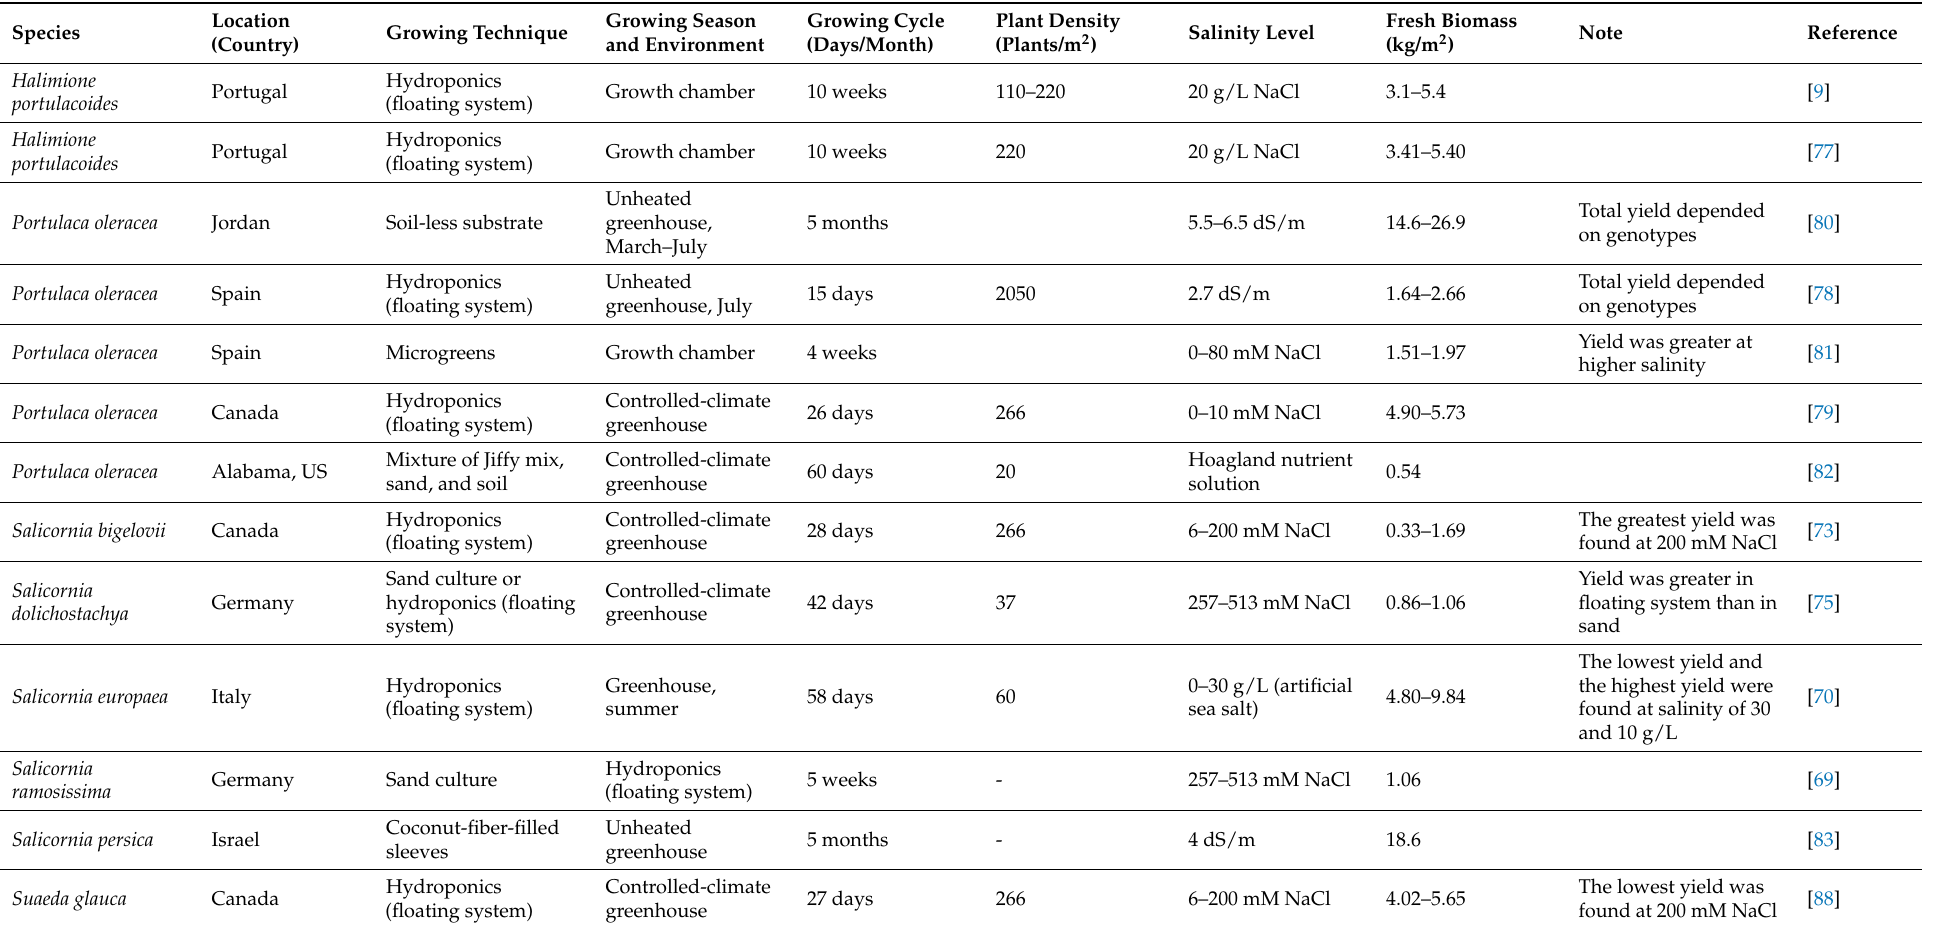
Table 2. Fresh biomass production of some halophytic species grown in hydroponics under different growing conditions, and at different plant density and salinity levels of the nutrient